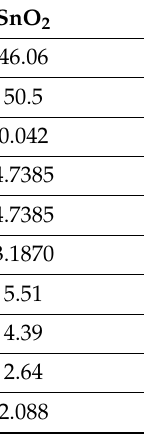
Table 3. Structure parameters of ZS–2 and ZT–2 by Rietveld refinement.